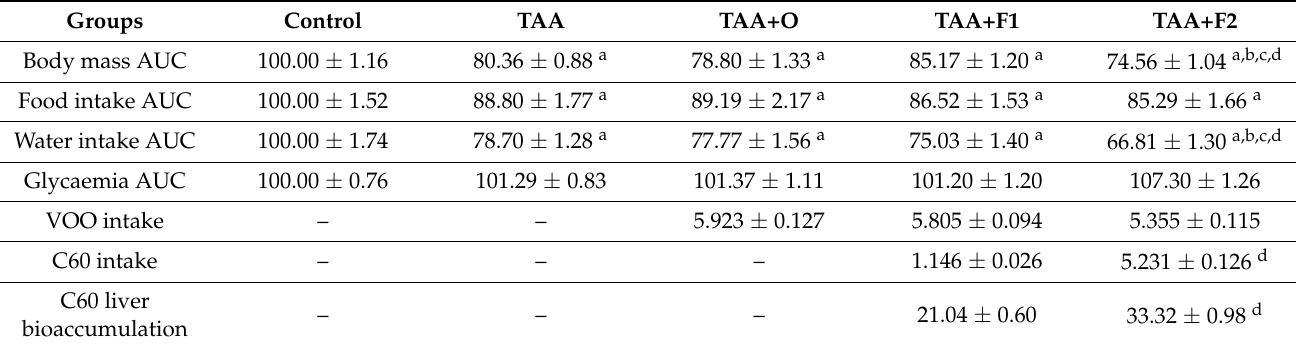
Table 2. The area under the curve (AUC, % of control) of the corresponding curves from Figure 1 (i.e., weekly body mass gain, daily food and water intake, and glycaemia), VOO (gr/kg b.m./day) and C60 fullerene (mg/kg b.m./day) average daily consumption during the whole experiment, and the liver C60 fullerene bioaccumulation ( µ g/g tissue) in control, and rats treated with thioacetamide (TAA), thioacetamide + virgin olive oil (TAA+O), thioacetamide + C60 fullerene lower dose (TAA+F1), and thioacetamide + C60 fullerene higher dose (TAA+F2). Data are given as mean ± standard error. Minimal significance level: p <